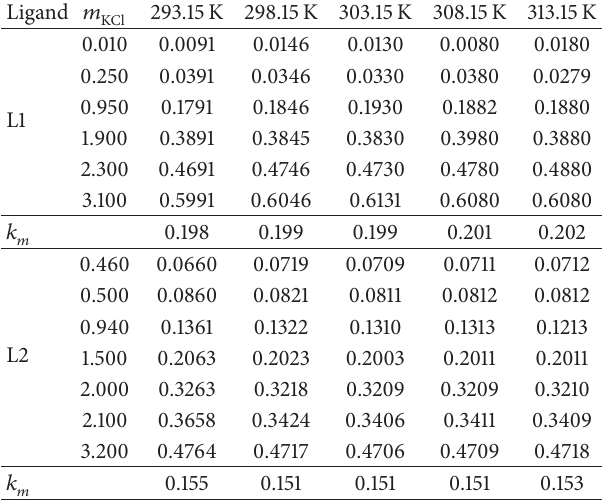
Table 7: Activity coefficients (log 𝛾 ) and the Setschenow coefficient ( 𝑘 𝑚 ) for the neutral species for L1 and L2 in aqueous KCl of different ionic strength and at different temperatures.